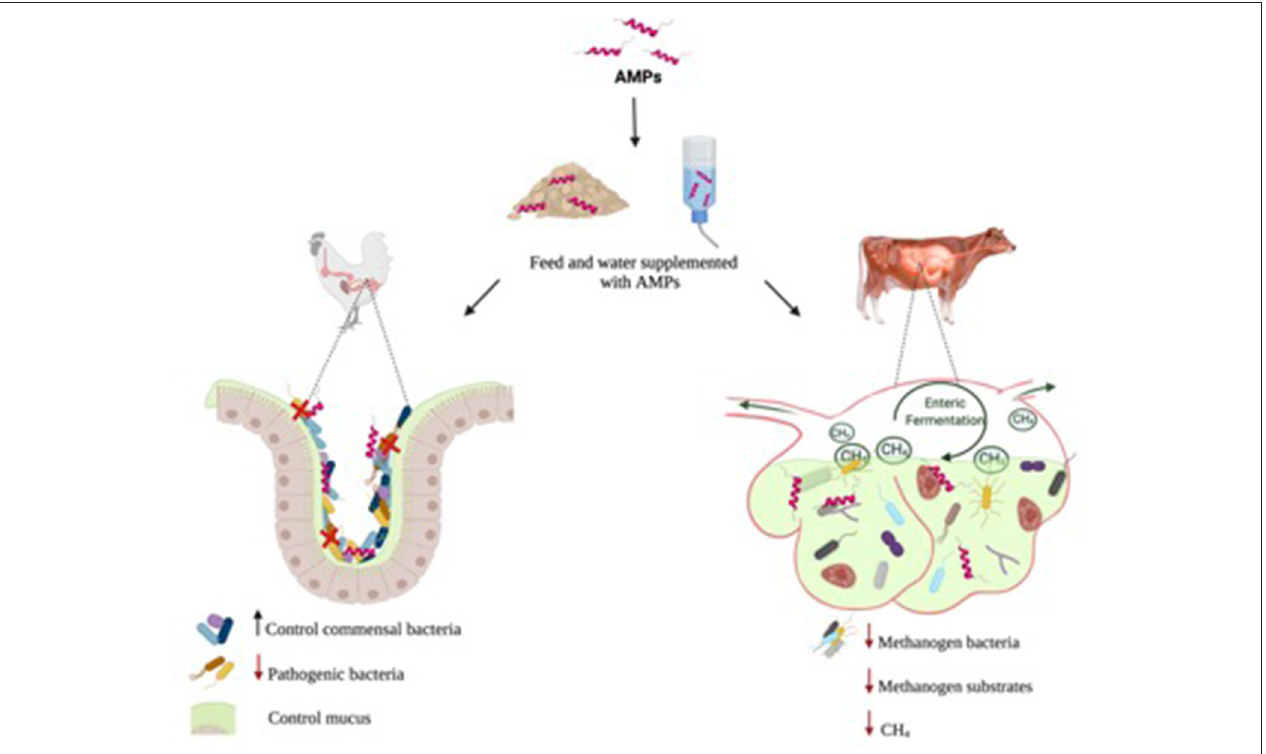
FIGURE 2 | Antimicrobial peptides (AMPs) affects intestinal mucosa and rumen: AMP as growth promoters in poultry and swine intestinal can act altering the composition of the microbiota to reduce competition for nutrients, reduce pathogen, and control mucus. In rumen the AMPs as growth promoters acting reducing the methanogen bacteria and substrates. In addition, decrease the rate of methane (CH 4 ) production and